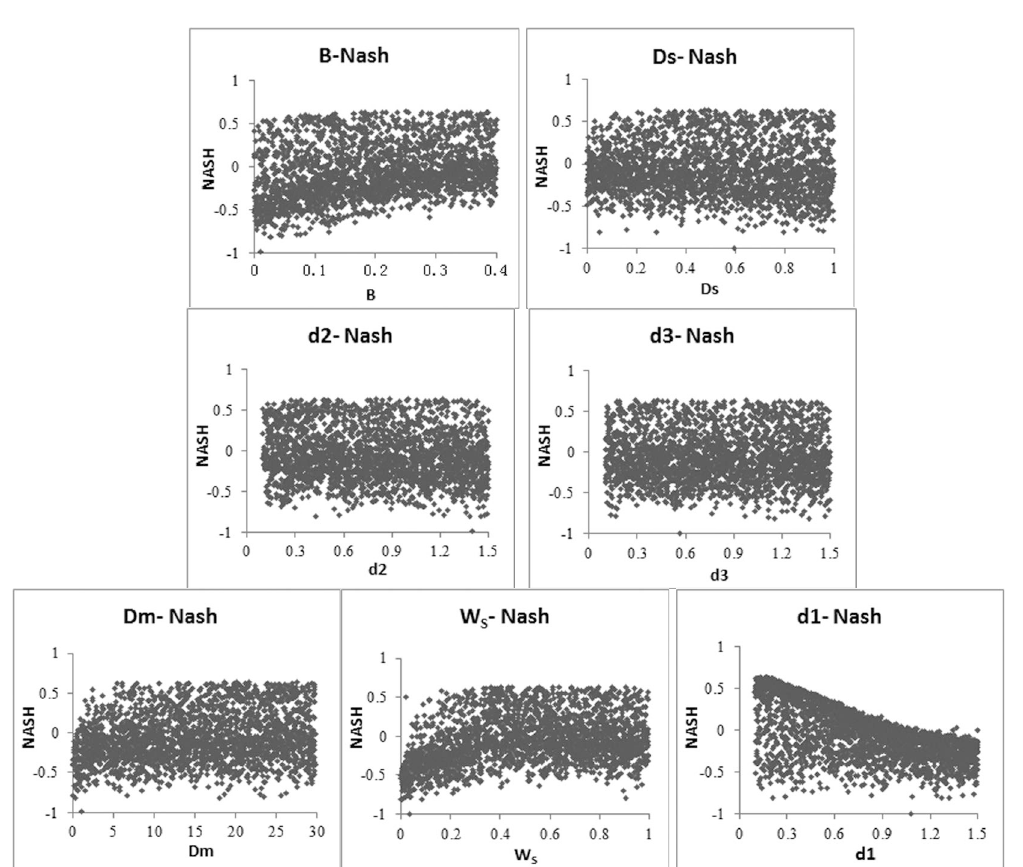
Fig. 3 Scatter plots of likelihood values for VIC